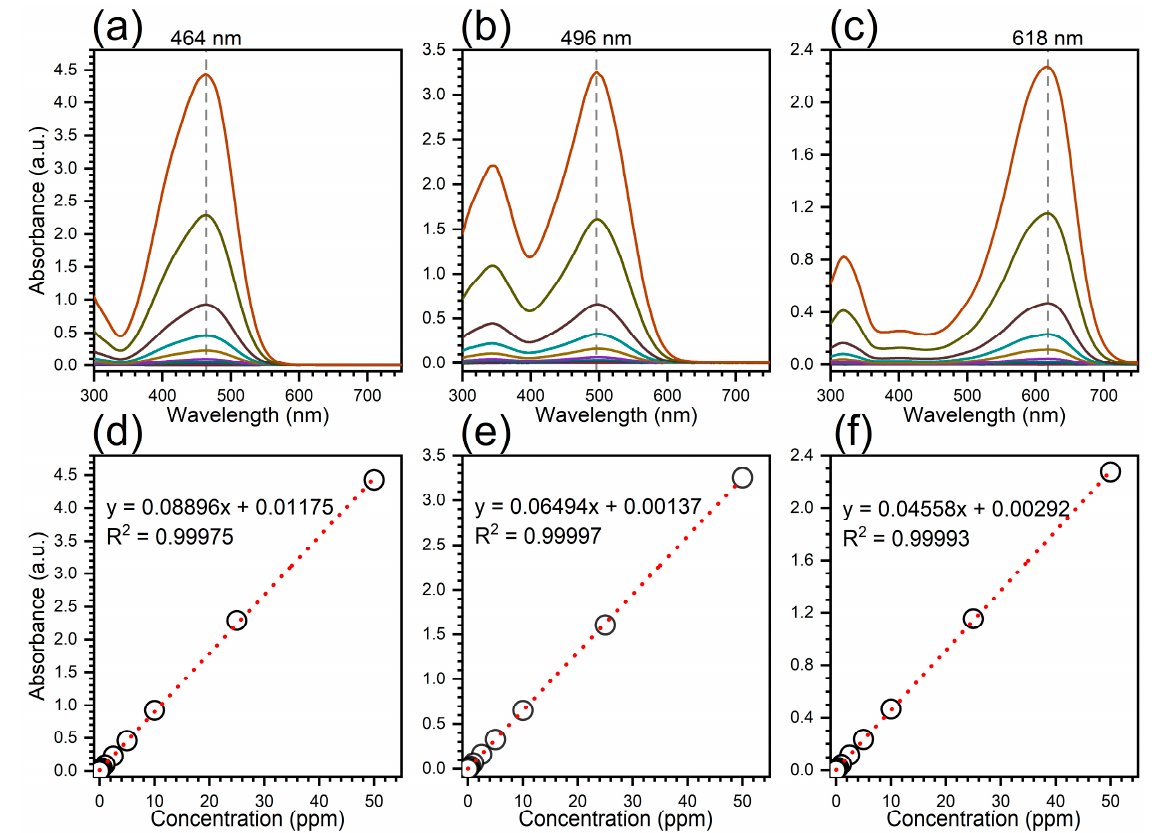
Figure 3. ( a – c ) UV/vis spectra of decreasing dye concentrations ( λ max denoted by the vertical dotted line) and ( d – f ) corresponding calibration curves with equations and linear regressions inset for methyl orange, Congo red, and Chicago Sky Blue 6B, respectively.